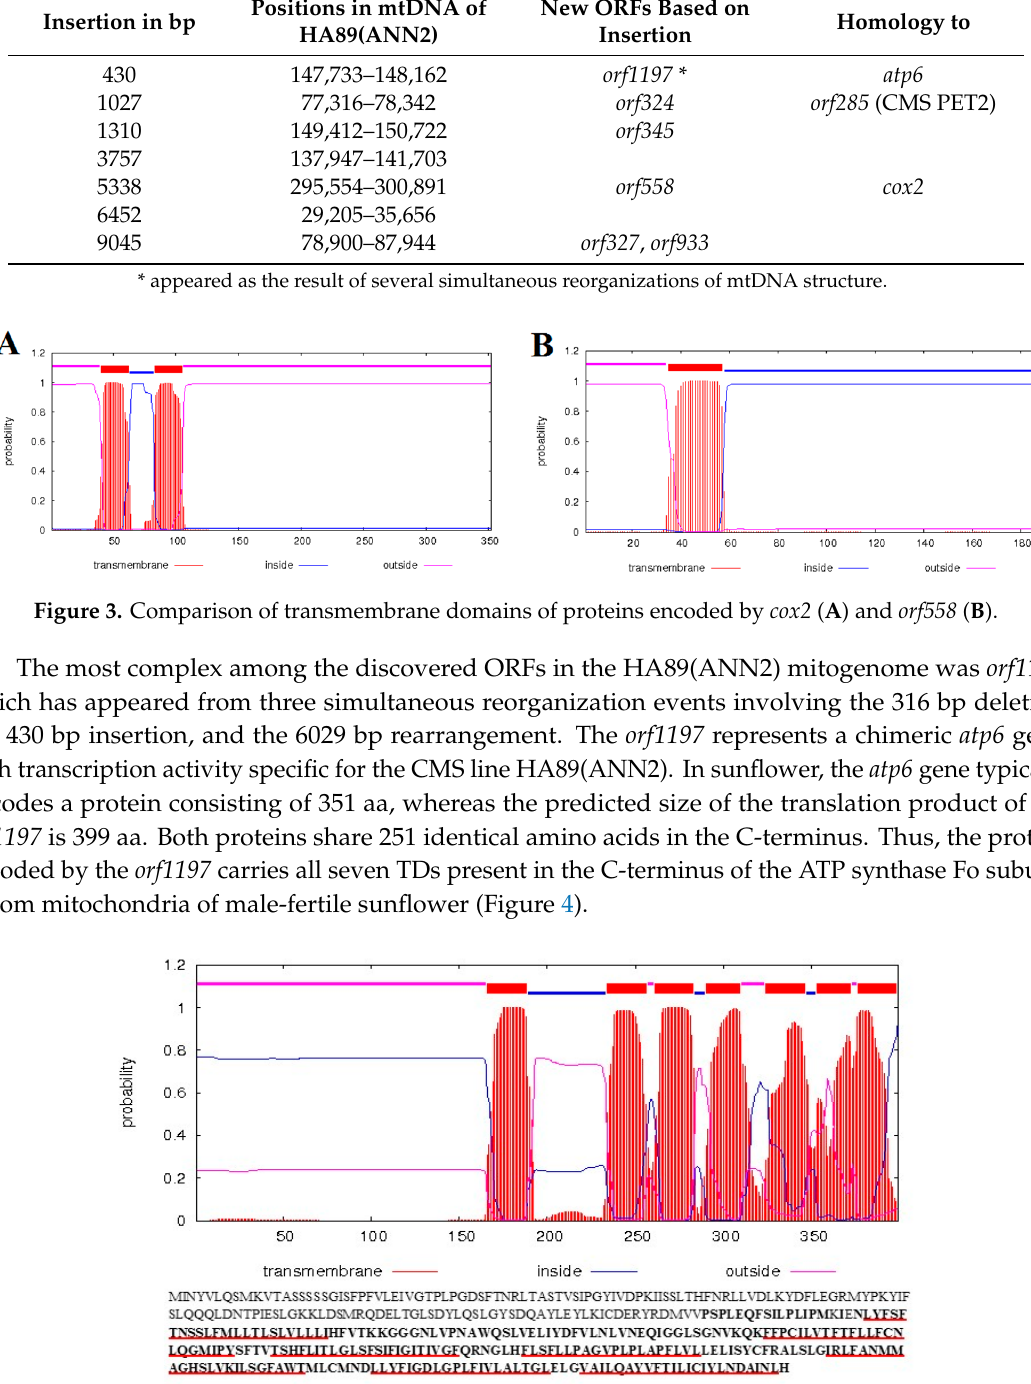
Figure 4. Comparison of orf1197 and atp6 encoded proteins and prediction of transmembrane helices. The amino acid sequence of the orf1197 encoded protein is presented. Amino acids identical to ATP6 are shown in bold. Amino acids forming transmembrane domains are marked by red bars.